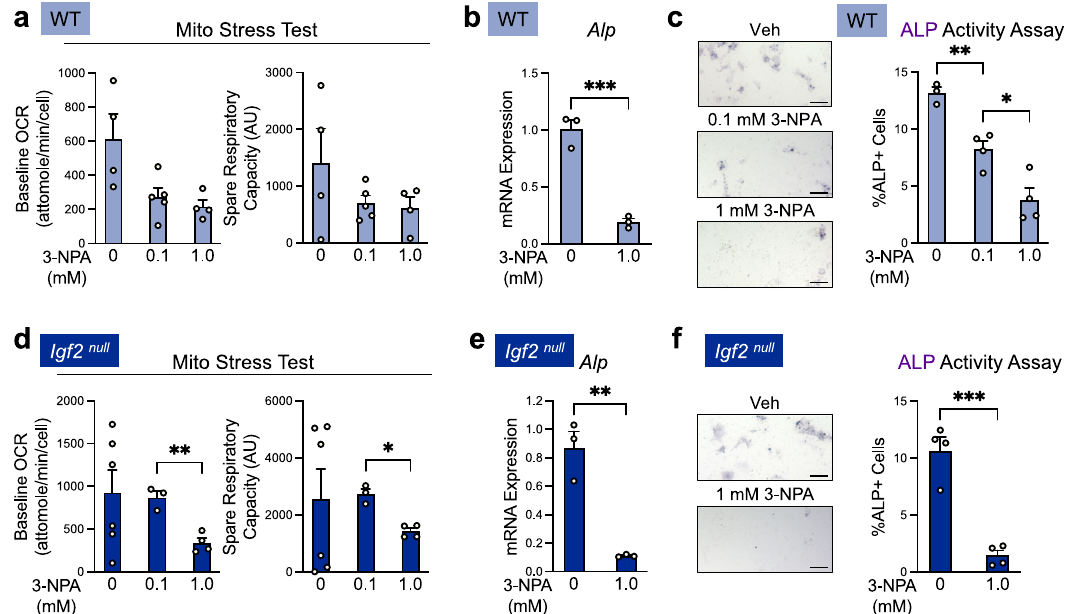
Fig. 4 Inhibition of oxidative phosphorylation in normal chondrocytes strongly inhibits hypertrophy in cultured epiphyseal chondrocytes. a Baseline and spare respiratory OCR measurements from Mito Stress Tests of WT hypertrophic epiphyseal chondrocytes treated with SDH inhibitor 3-NPA, showing that 3-NPA inhibits OxPhos. Representative of n = 3 experiments with 3 – 6 wells per group. b RT-qPCR analysis of hypertrophic marker alkaline phosphatase (ALP) in WT hypertrophic epiphyseal chondrocytes treated with 3-NPA. Representative of n = 2 experiments with 3 wells per group. c Alkaline phosphatase activity assay of WT hypertrophic chondrocytes treated with 3-NPA. Representative of n = 3 experiments with 2 – 4 wells per group. Scale bar: 200 µ m. d Baseline and spare respiratory capacity OCR measurements of Igf2 null hypertrophic epiphyseal chondrocytes treated with 3-NPA. Representative of n = 3 experiments with 3 – 6 wells per group. e Gene expression of hypertrophic marker alkaline phosphatase as measured by RT-qPCR in Igf2 null hypertrophic epiphyseal chondrocytes treated with 3-NPA. Representative of n = 2 experiments with 3 wells per group. f Igf2 null hypertrophic chondrocytes treated with 3-NPA were detected and quanti fi ed by staining for alkaline phosphatase activity. Representative of n = 3 experiments with 2 – 4 wells per group. Scale bar: 200 µ m. Data are presented as individual measurements with mean + SEM. Note that the control data (0 mM 3-NPA) for b and e are also shown in Fig. 6. Statistical signi fi cance was calculated by Brown – Forsythe and Welch ANOVAs with Dunnett ’ s T3 test for multiple comparisons ( a , c , d ) or unpaired two-tailed t -test ( b , e , f ). p -values indicated as * p < 0.05, ** p < 0.01, *** p <